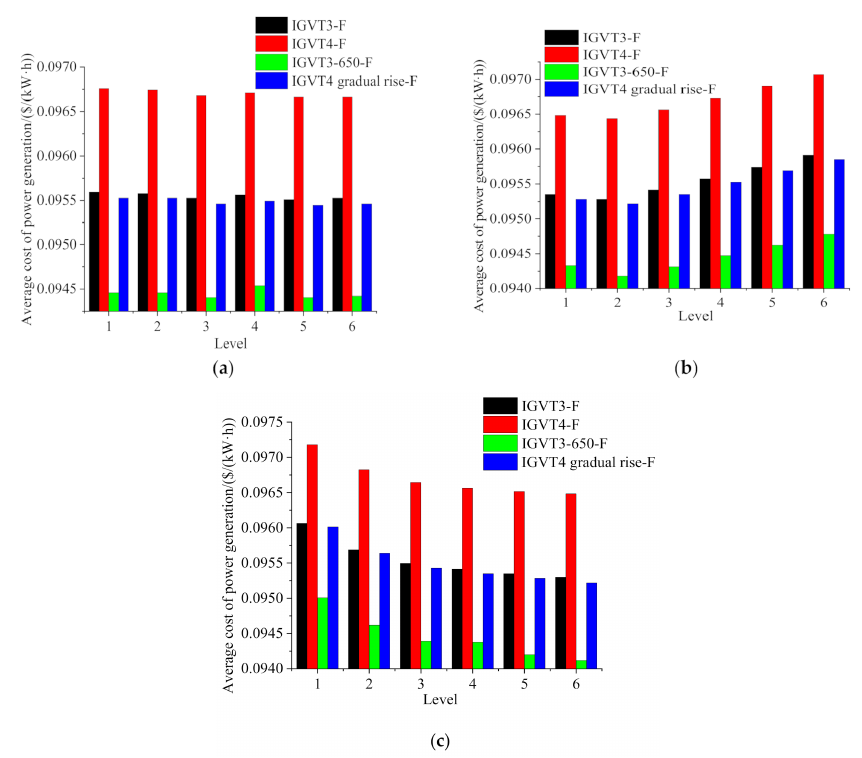
Figure 6. The average power generation cost under all levels (GT 75% load rate). ( a ) LP ( b ) IP ( c )